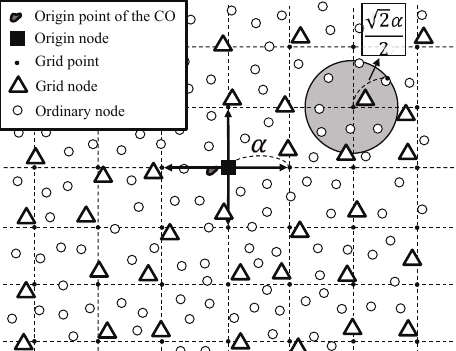
Figure 10. Construction of the origin-based grid